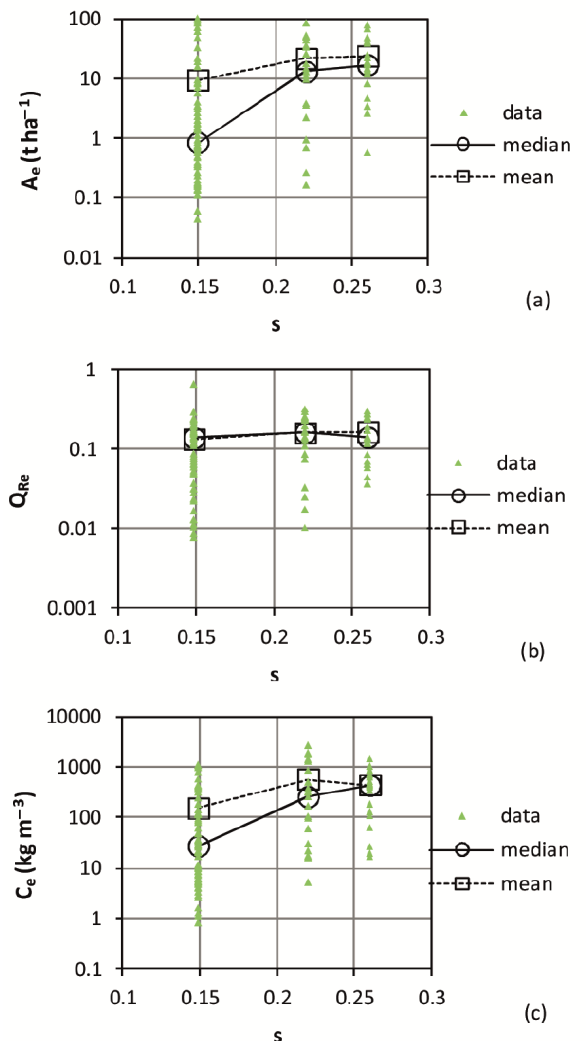
Figure 7. Plot steepness, s , effect on event ( a ) soil loss per unit area, A e , ( b ) runoff coefficient, Q Re , and ( c ) sediment concentration, C e , for the 22 m long plots (modified from [30]).